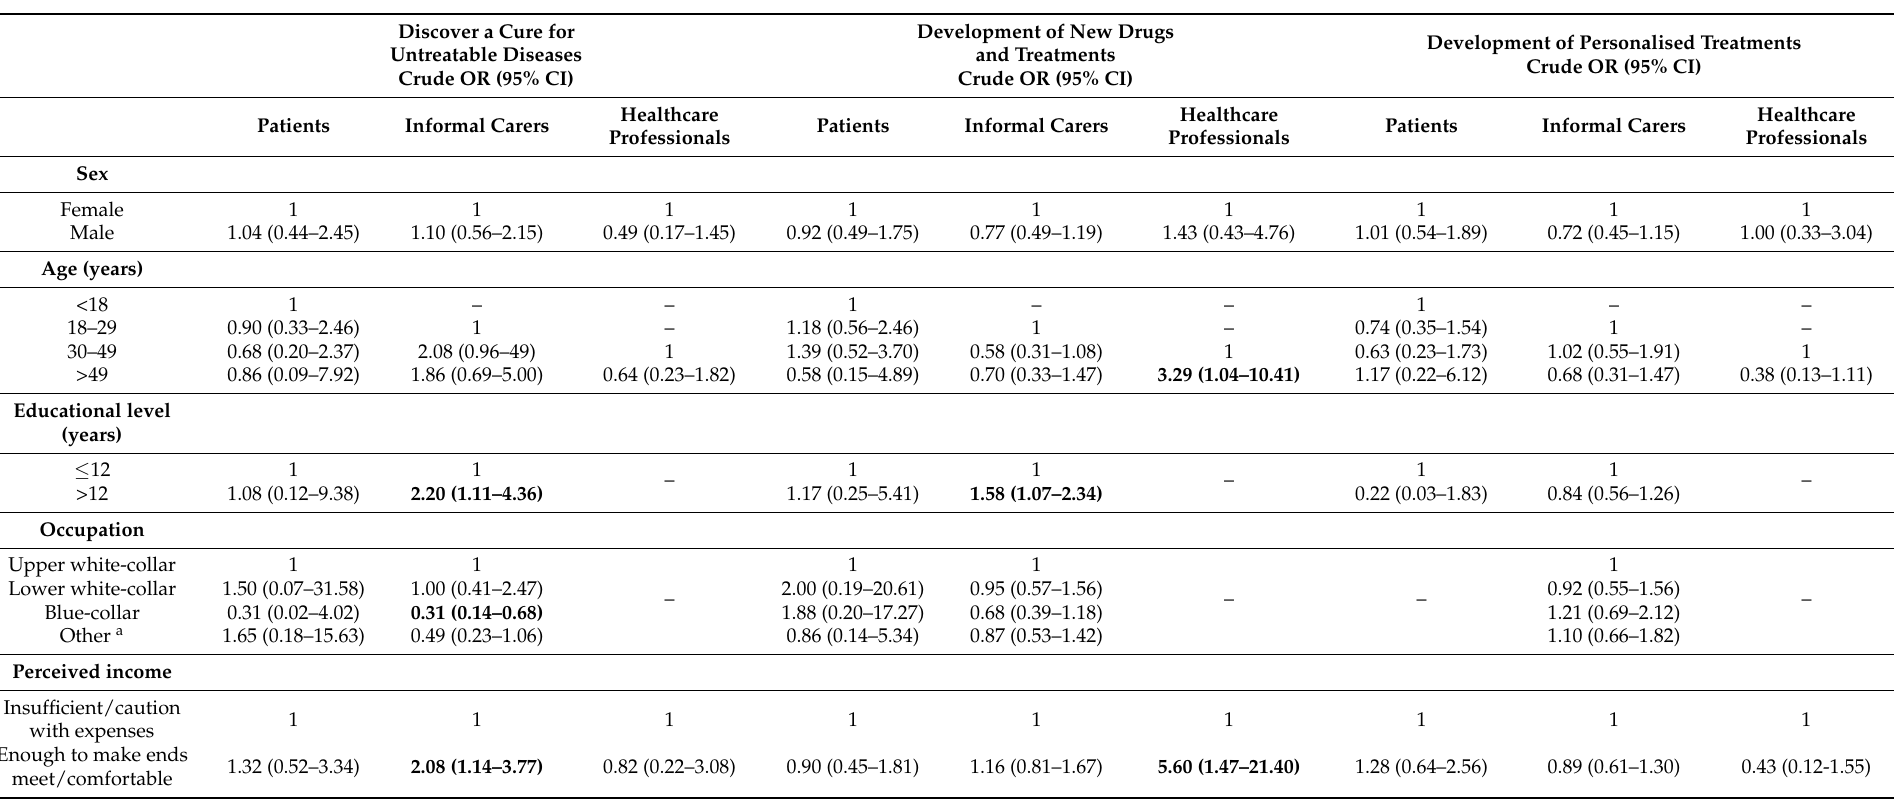
Table 3. Factors associated with selecting the benefits of sharing genetic information for research, stratified by type of